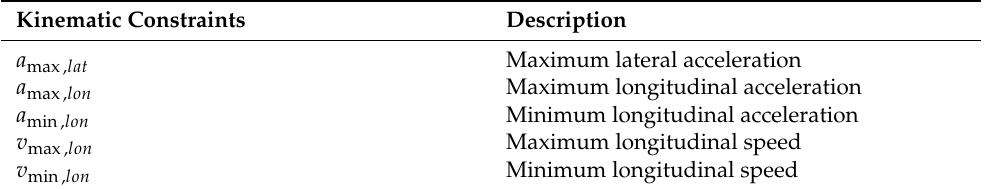
Table 1. The motion limits.